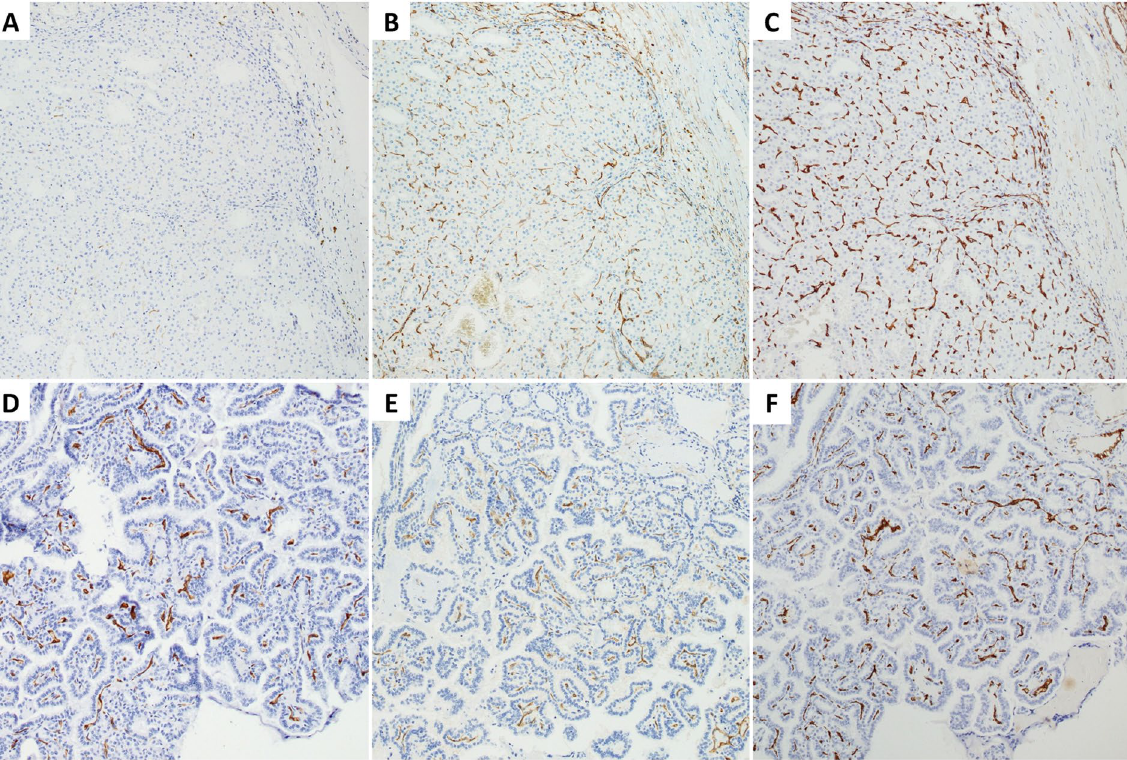
Figure 3. Coexpression of PSMA and endothelial markers. ( A – C ) Follicular thyroid carcinoma with negative expression of PSMA (proportion score < 5%) versus strongly positive CD105 and CD34. ( D – F ) Papillary thyroid carcinoma with concordant expression of PSMA, CD105, and CD34. Immunohistochemistry with anti- PSMA ( A , D ), anti-CD105 ( B , E ), and anti-CD34 ( C , F ). Serial sections, 100 ×